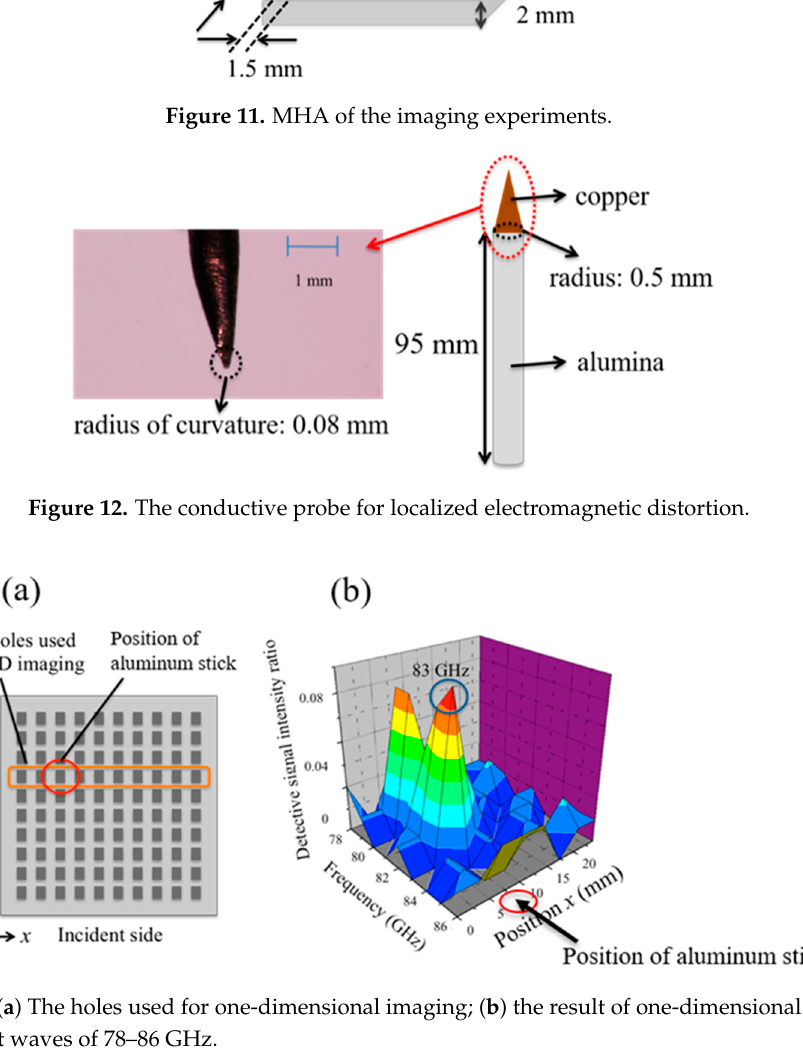
Figure 13. ( a ) The holes used for one-dimensional imaging; ( b ) the result of one-dimensional imaging for incident waves of 78–86